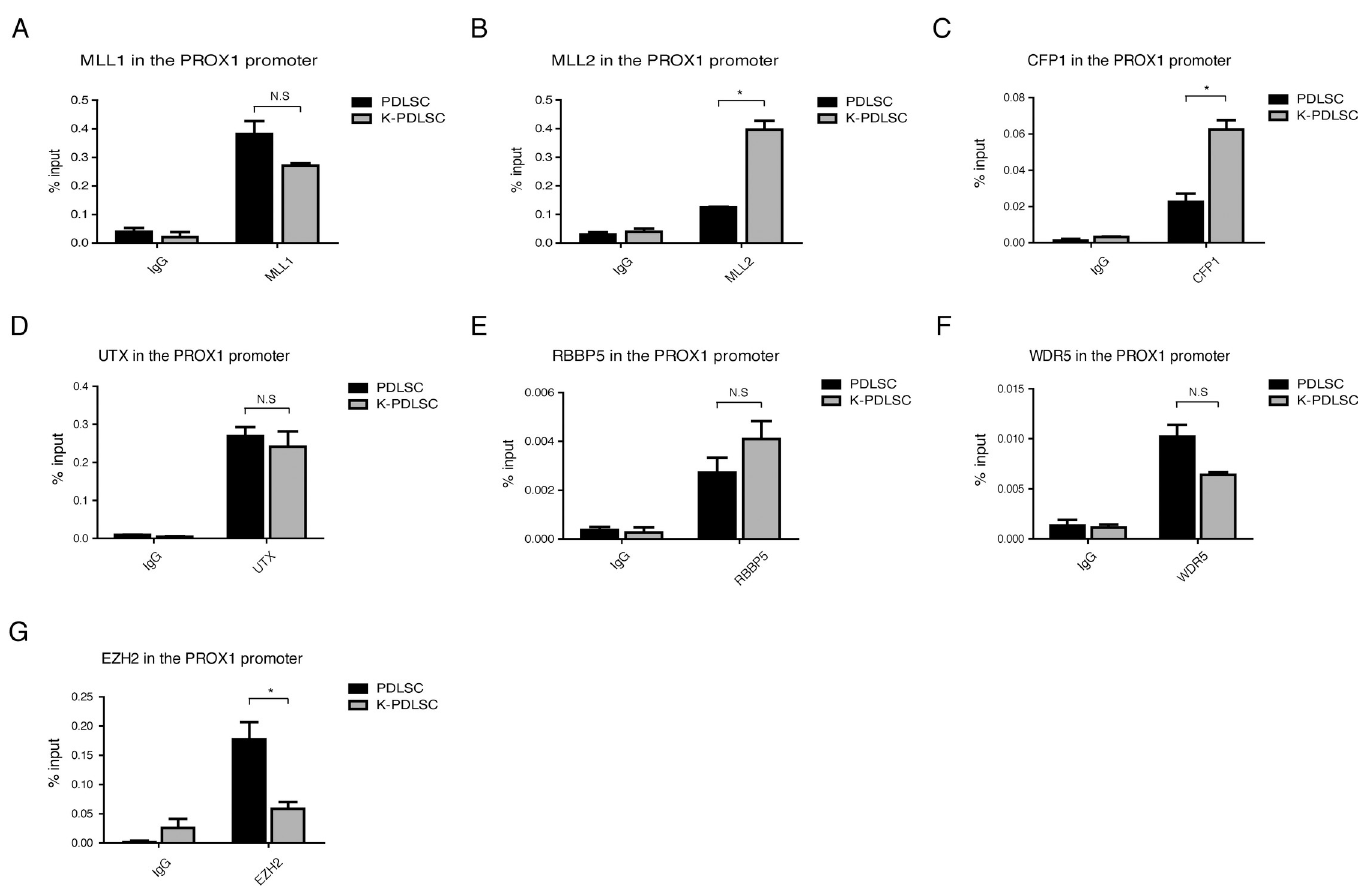
Fig 4. KSHV resolves the PROX1 bivalent chromatin by recruiting MLL2 and CFP1 and removing PRC2 to the PROX1 Promoter. Mock- and KSHV-infected PDLSCs were subjected to ChIP assay with antibodies against different histone methyltransferase components, including MLL1, MLL2, CFP1, UTX, RBBP5, WDR5, and EZH2 (a component of PRC2). Error bars represent SD. Statistics analysis was performed using the one-way ANOVA test. P-values < 0.05 were considered significant ( � P < 0.05, �� P < 0.01 and ��� P < 0.001) and N.S represents no significance.